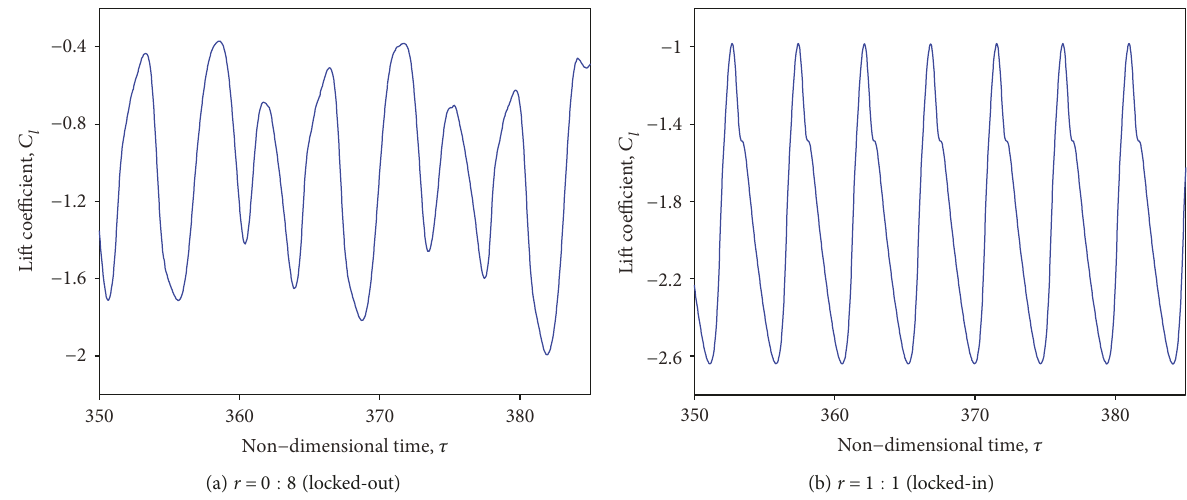
Figure 3: Detail of the time record of the lift force coe ffi cient at α = 140 ° , for di ff erent frequency ratios showing the e ff ect of lock-out (a) and lock-in